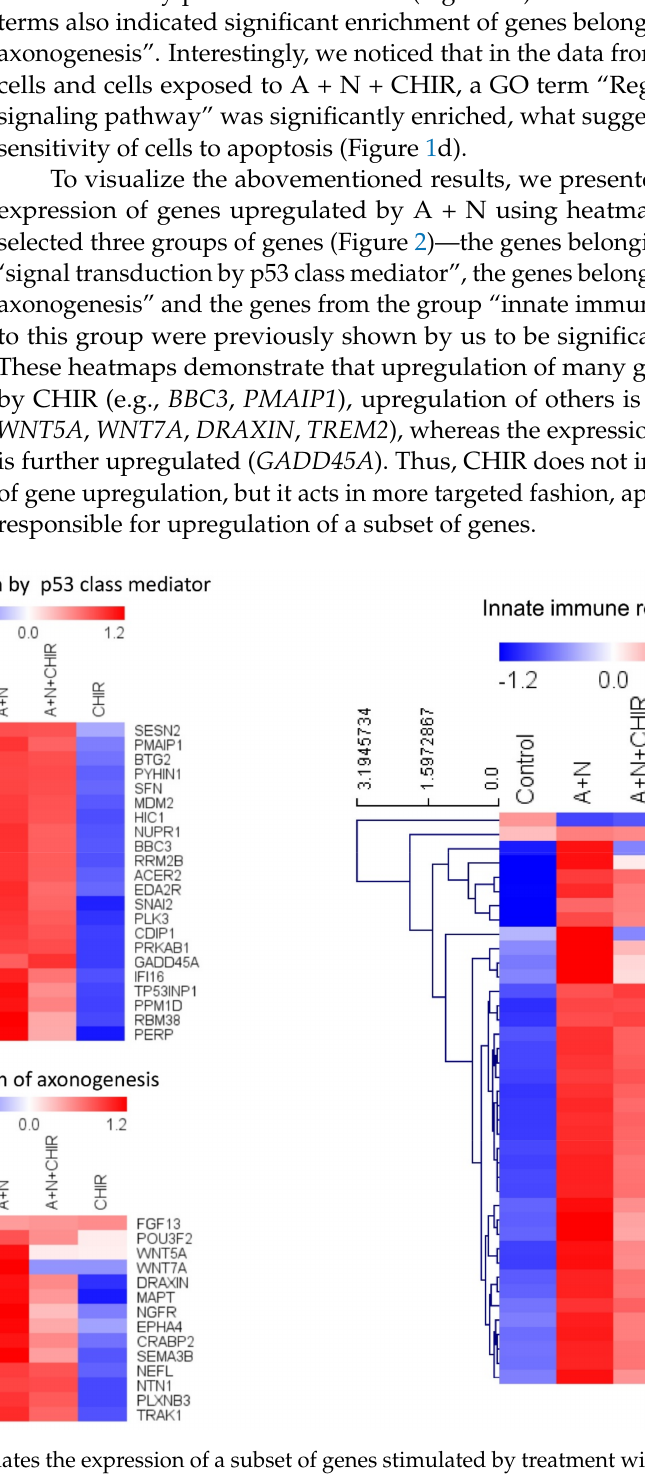
Figure 2. CHIR-98014 attenuates the expression of a subset of genes stimulated by treatment with actinomycin D + nutlin-3a (A + N). Heatmaps demonstrating the RNA-seq expression of genes belonging to selected Gene Ontology groups in control cells and the cells exposed as indicated. In order to generate heatmaps control sample measurements were averaged across three